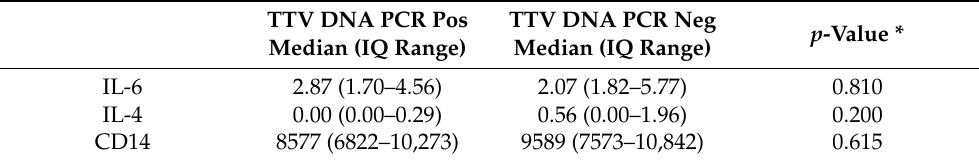
Table 4. Association of cytokines with TTV DNA positivity.